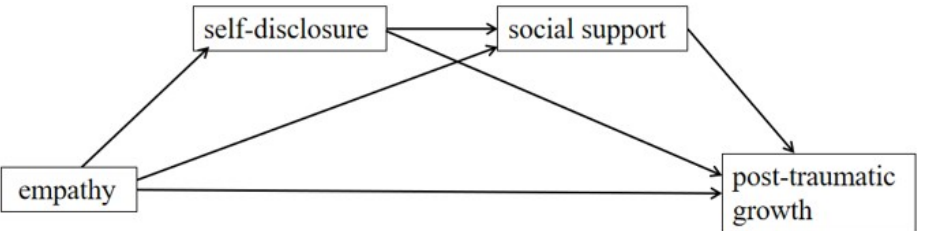
Figure 1. Proposed multiple mediating model.